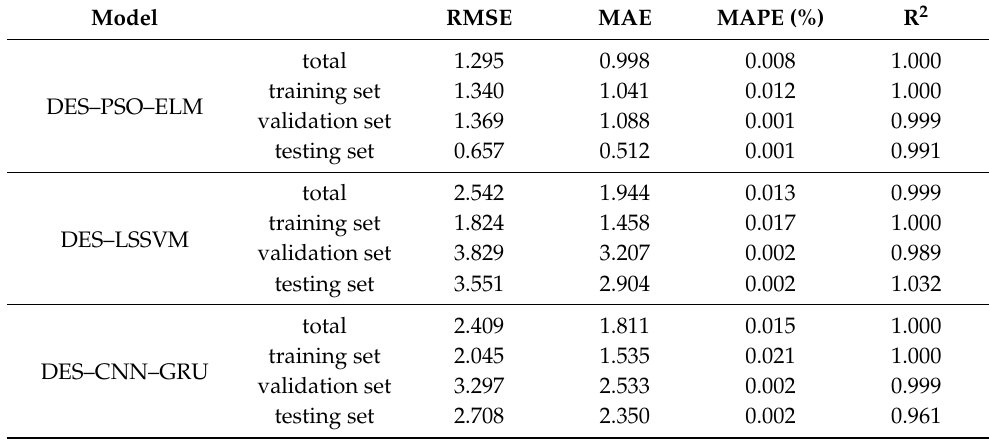
Table 1. Comparison of different models for periodic displacement prediction (July 2016 to July 2020).